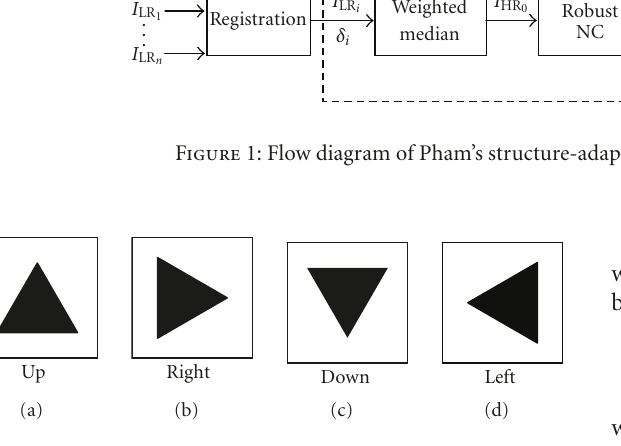
Figure 2: The four di ff erent stimuli used in the TOD